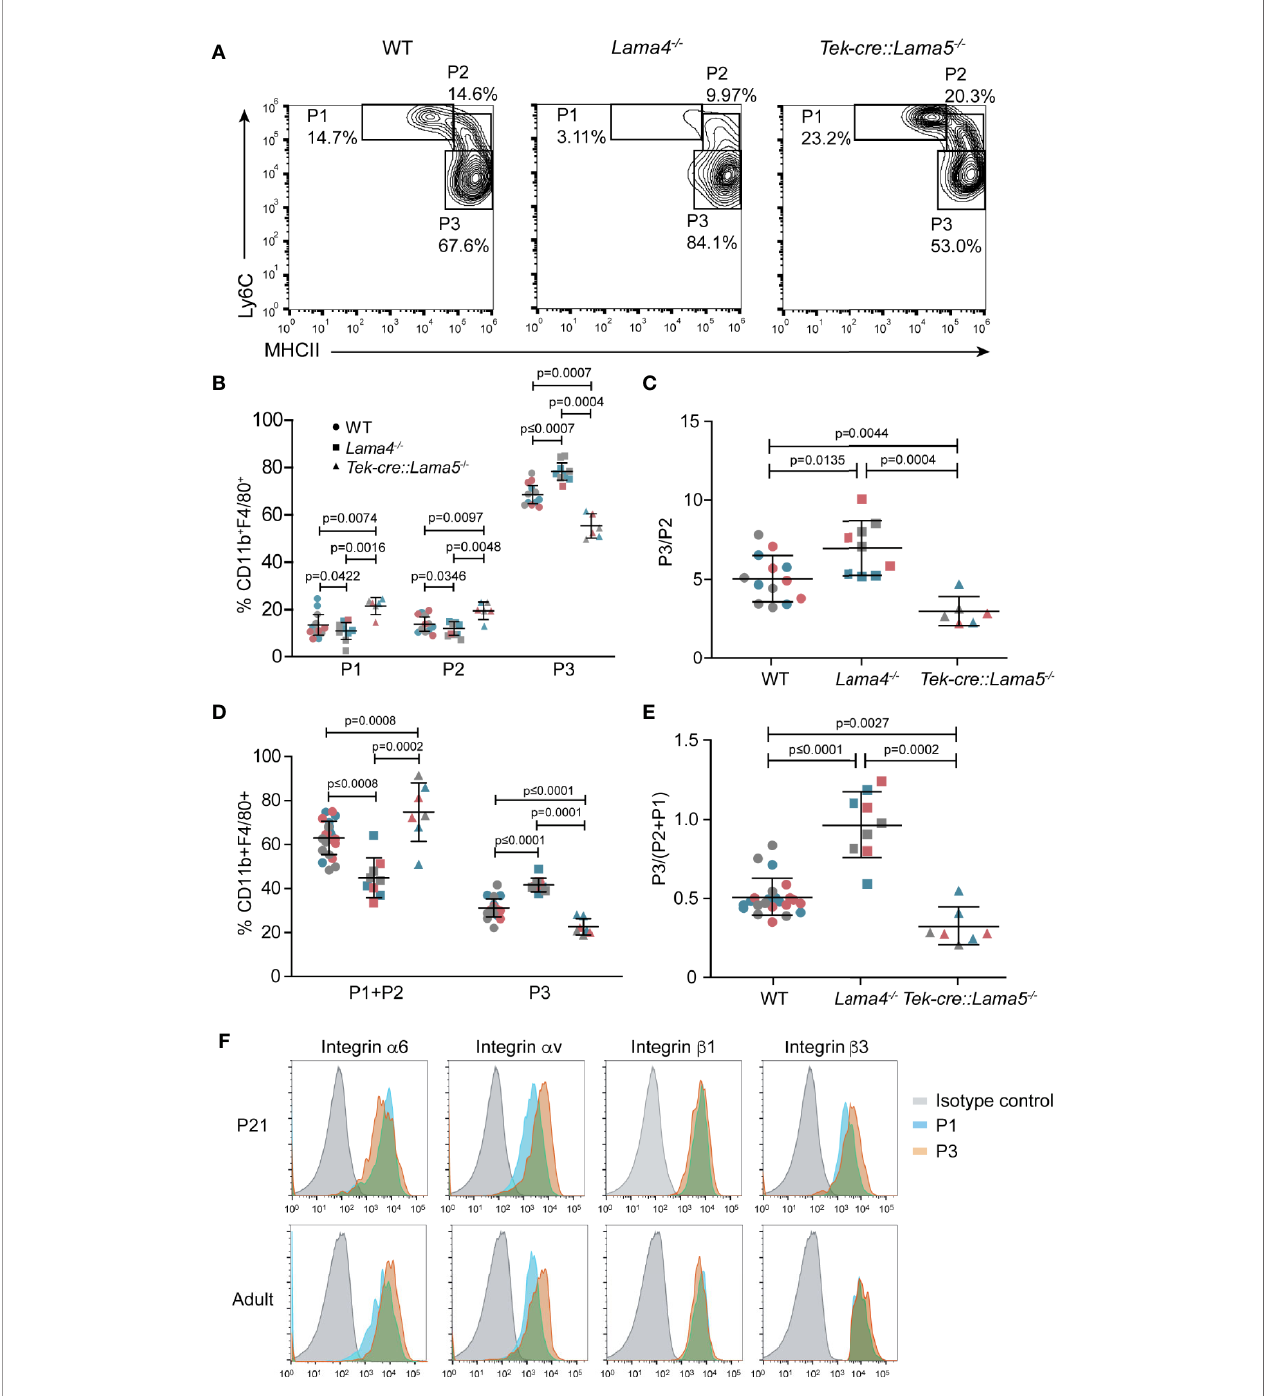
FIGURE 4 | Monocyte differentiation in colons of Lama4 − / − and Tek-cre::Lama5 − / − mice. (A) Representative fl ow cytometry showing proportions of early extravasating P1 (Ly6C hi MHCII low ) and P2 (Ly6C mid MHCII mid ) populations, and mature P3 macrophages (Ly6C low MHCII hi ) in isolated colonic lamina propria cells from adult WT, Lama4 − / − and Tek-cre::Lama5 − / − mice; (B) corresponding quanti fi cation of the data and (C) ratios of P3/P2 cells. Data are means ± SD from three independent experiments (marked in different colors) performed with 13 WT, 9 Lama4 − / − , and 6 Tek-cre::Lama5 − / − mice. (D) Corresponding analyses of P1 plus P2 populations, and mature P3 macrophages amongst colonic lamina propria cells of P21 WT, Lama4 − / − and Tek-cre::Lama5 − / − mice; and (E) ratios of P3/P2+P1 cells. Data are means ± SEM from three experiments (marked in different colors) performed with 23 WT, 9 Lama4 − / − , and 7 Tek-cre::Lama5 − / − mice (marked by different symbols). Signi fi cance of the data was calculated using a Mann-Whitney test; exact p -values are shown in the graph. (F) Representative fl ow cytometry of laminin binding integrins on colon P1, P2, and P3 cells from adult and P21 WT mice. The experiment was repeat three times with the same pattern of